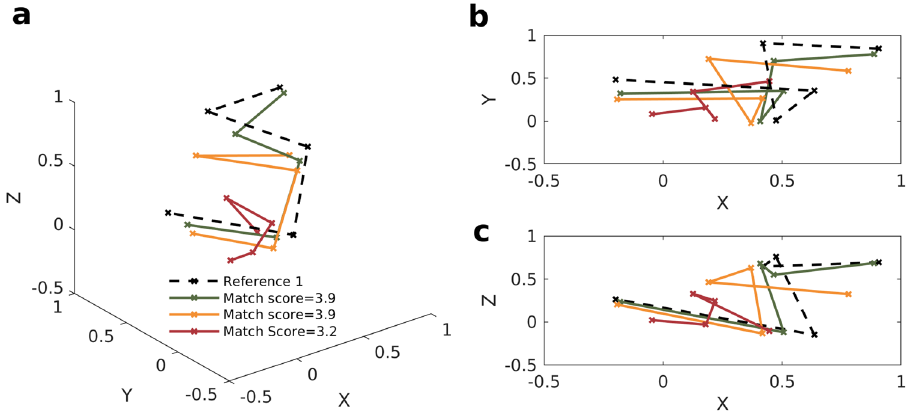
Figure 3. Location and scale (pattern size) invariance of the rdFC pattern matching algorithm. ( a ) Three sample rdFC patterns of different sizes and at different locations that give a statistically significant match score with reference 1. The three patterns were obtained from three different triplets in the EEG of a subject who was part of a past study 45 . All the 3-dimensional patterns have been projected in the ( b ) X–Y and ( c ) X–Z plane for a precise visual comparison of their